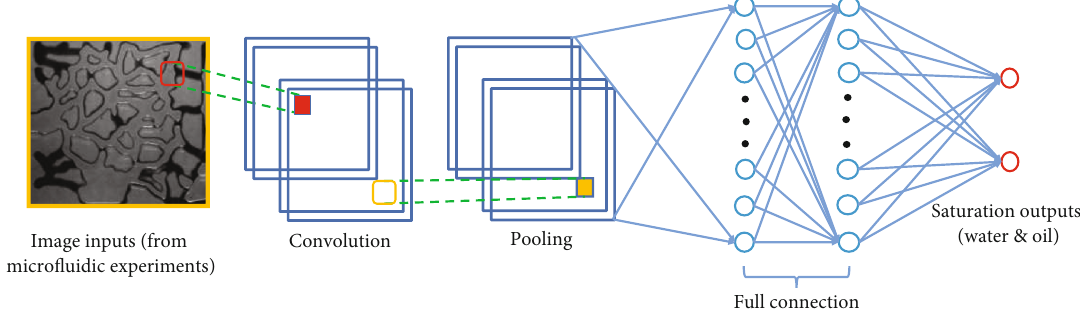
Figure 4: Schematic diagram of the convolution neural network (CNN) for saturation